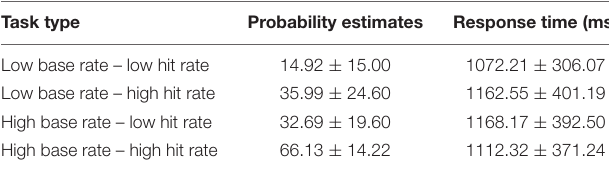
TABLE 1 | The average posterior probability and reaction times for the four reasoning tasks from 18 participants (M ±